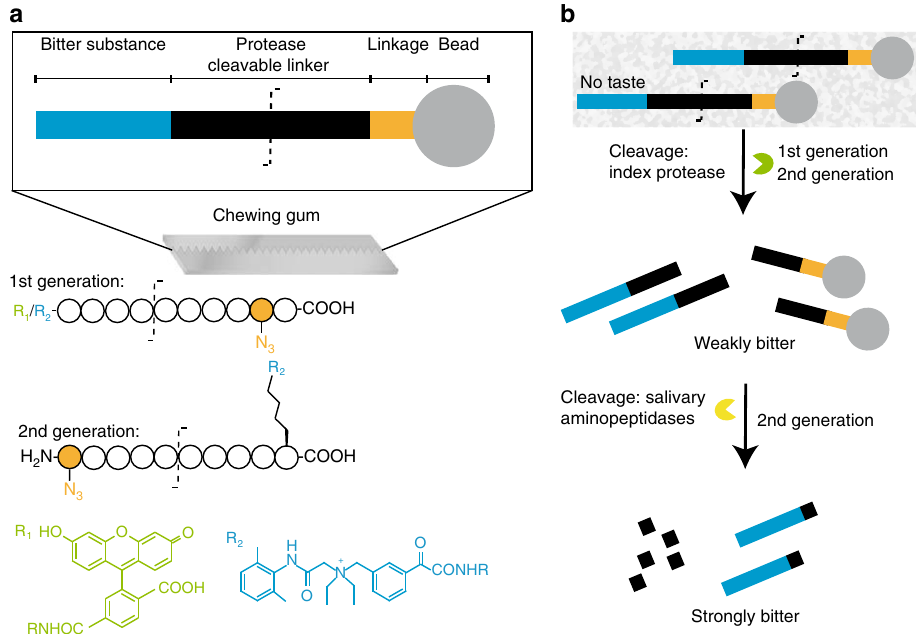
Fig. 1 Cartoon outlining the functionality of the sensors. a Particle-bound protease cleavable linkers (PCL) with denatonium carboxylate derivate and schematic presentation of the PCL denatonium conjugates. First-generation sensors had the rests R 1 carboxy fl uorescein, R 2 denatonium carboxylate) attached to the PCL ’ s N-terminus. Second-generation sensors had the denatonium carboxylate attached to the ε − amino group of a C-terminal lysine. b Salivary MMPs cleave the sensor speci fi cally, thereby creating a peptide denatonium fragment with a weak bitter taste. Second-generation sensors were designed such that this peptide denatonium fragment was substrate for salivary aminopeptidases resulting in further degradation of the peptide. This additional reduction of size of the peptide denatonium fragment increases bitterness. The orange- fi lled amino acid is azido